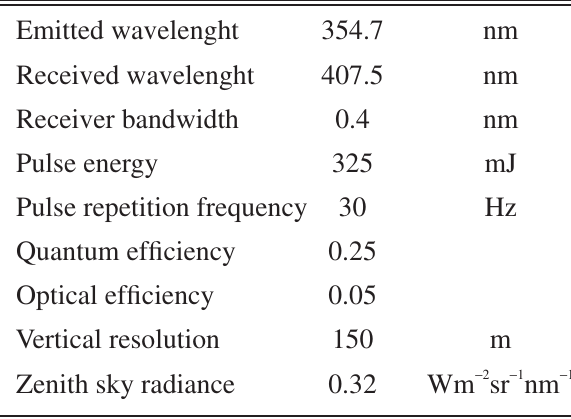
Table II. Lidar system. constants considered for simulation.